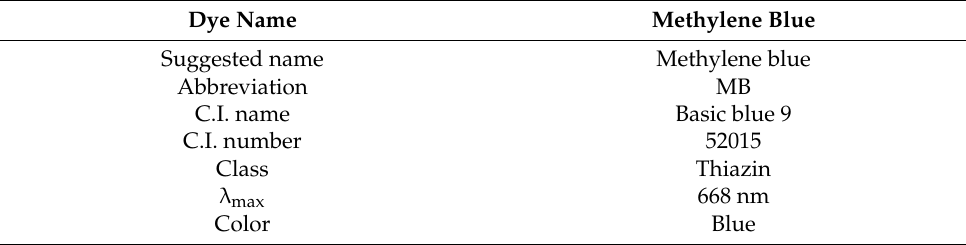
Table 6. Physical characteristics and molecular structure of Methylene